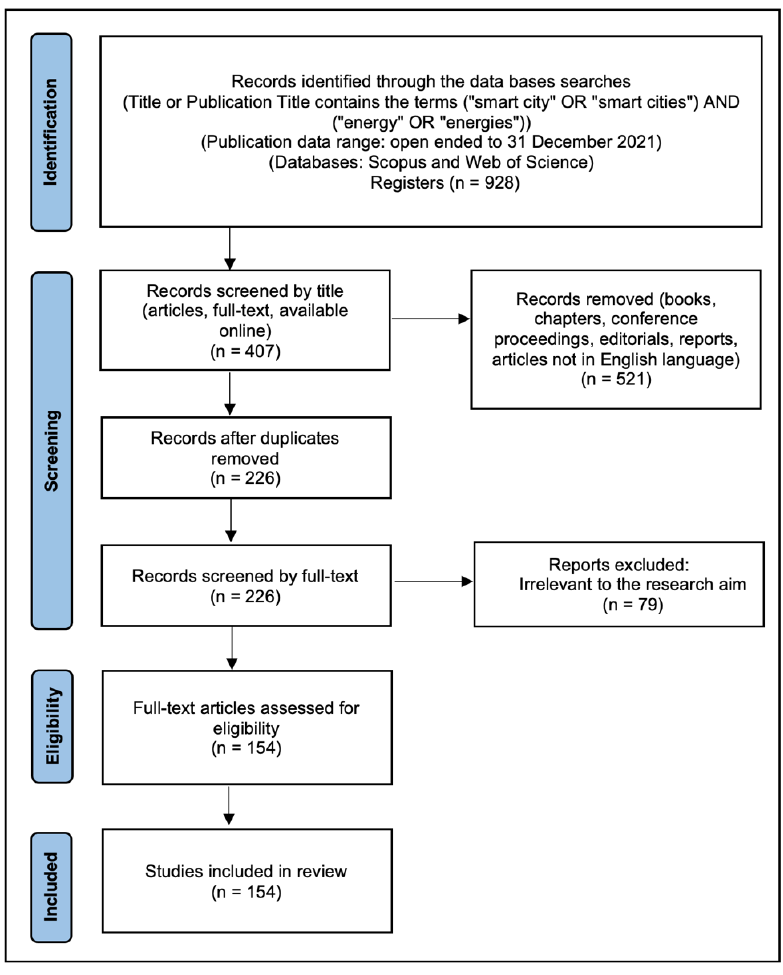
Figure 3. The PRISMA selection process of relevant literature.